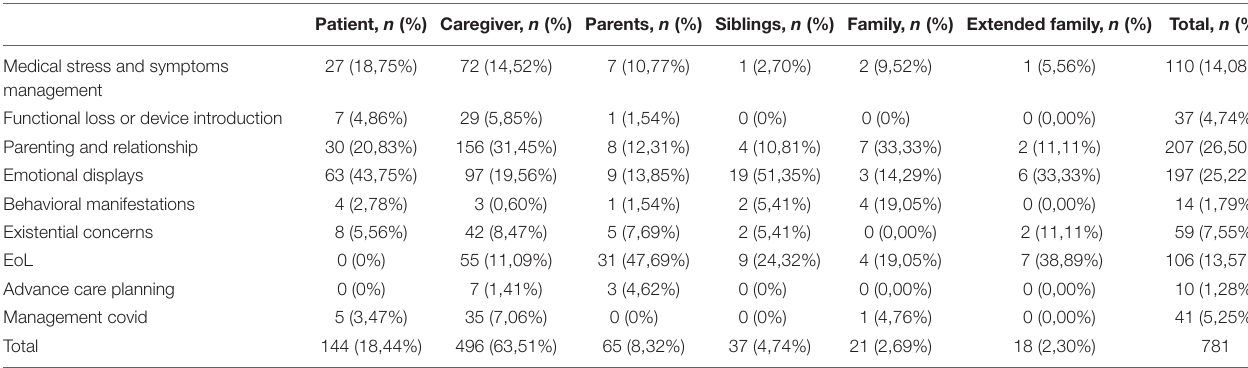
TABLE 2 | Thematic areas.